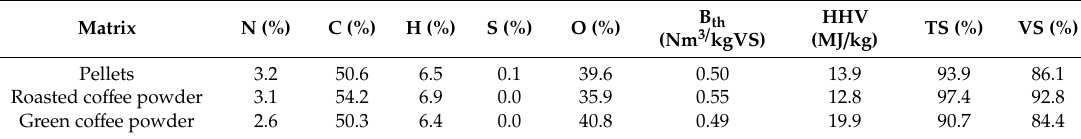
Table 4. Elemental characterizations of the three considered